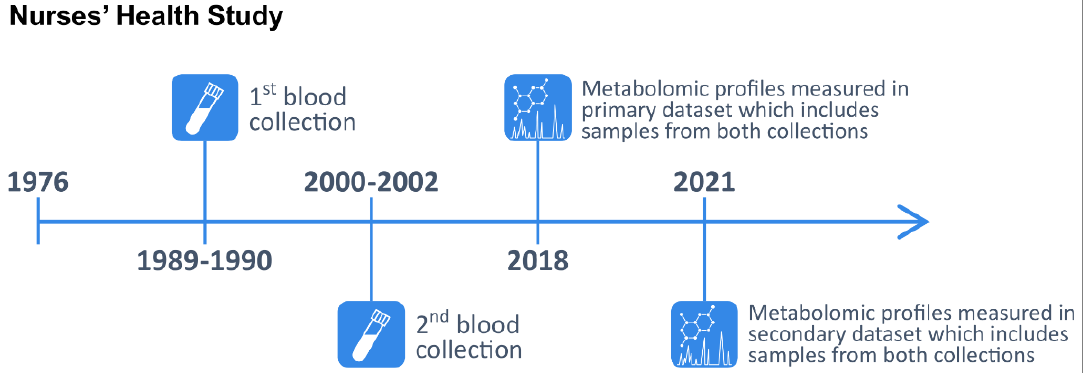
Figure 3. Timeline of the two blood collections and metabolomic profiling in the primary and secondary datasets within the Nurses’ Health Study.